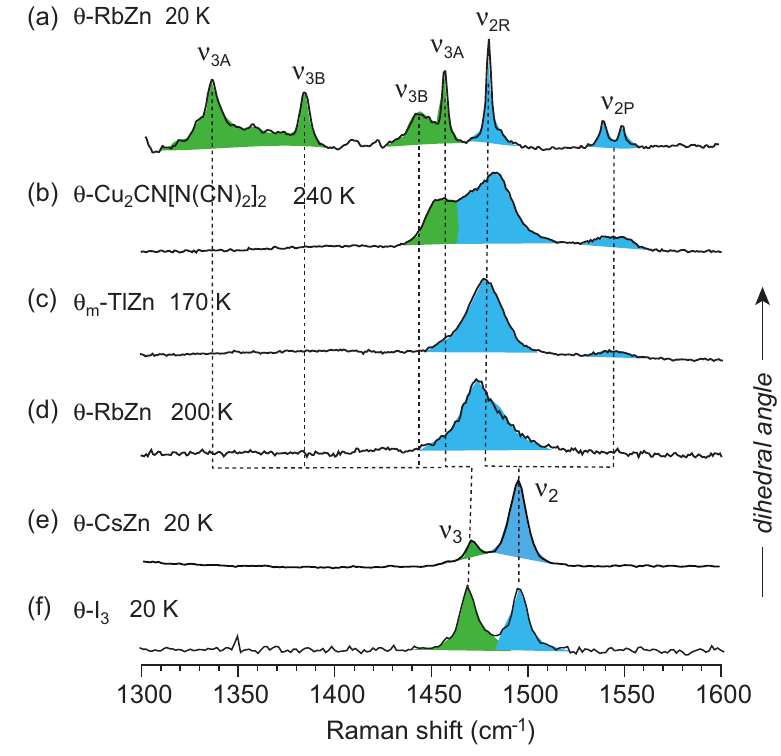
Figure 14. Comparison of the Raman spectra of ( a ) the CO state of θ -(BEDT-TTF) 2 RbZn(SCN) ; ( b ) high-temperature phase of θ -(BEDT-TTF) Cu CN[N(CN) ] ; and the 4 2 2 2 2 -(BEDT-TTF) TlZn(SCN) ; ( d ) θ -(BEDT-TTF) RbZn(SCN) ; metallic phase of ( c ) θ m 2 4 2 4 CsZn(SCN) ; and ( f ) θ -(BEDT-TTF) I . Note that the ν mode is split ( e ) θ -(BEDT-TTF) 2 4 2 3 2 is merged in (e) and (f). The assignments in θ -(BEDT-TTF) in (a), (b), (c), and (d), while ν 2 2 MZn(SCN) (M = Rb, Cs) in the metallic phase are conducted with the aid 4